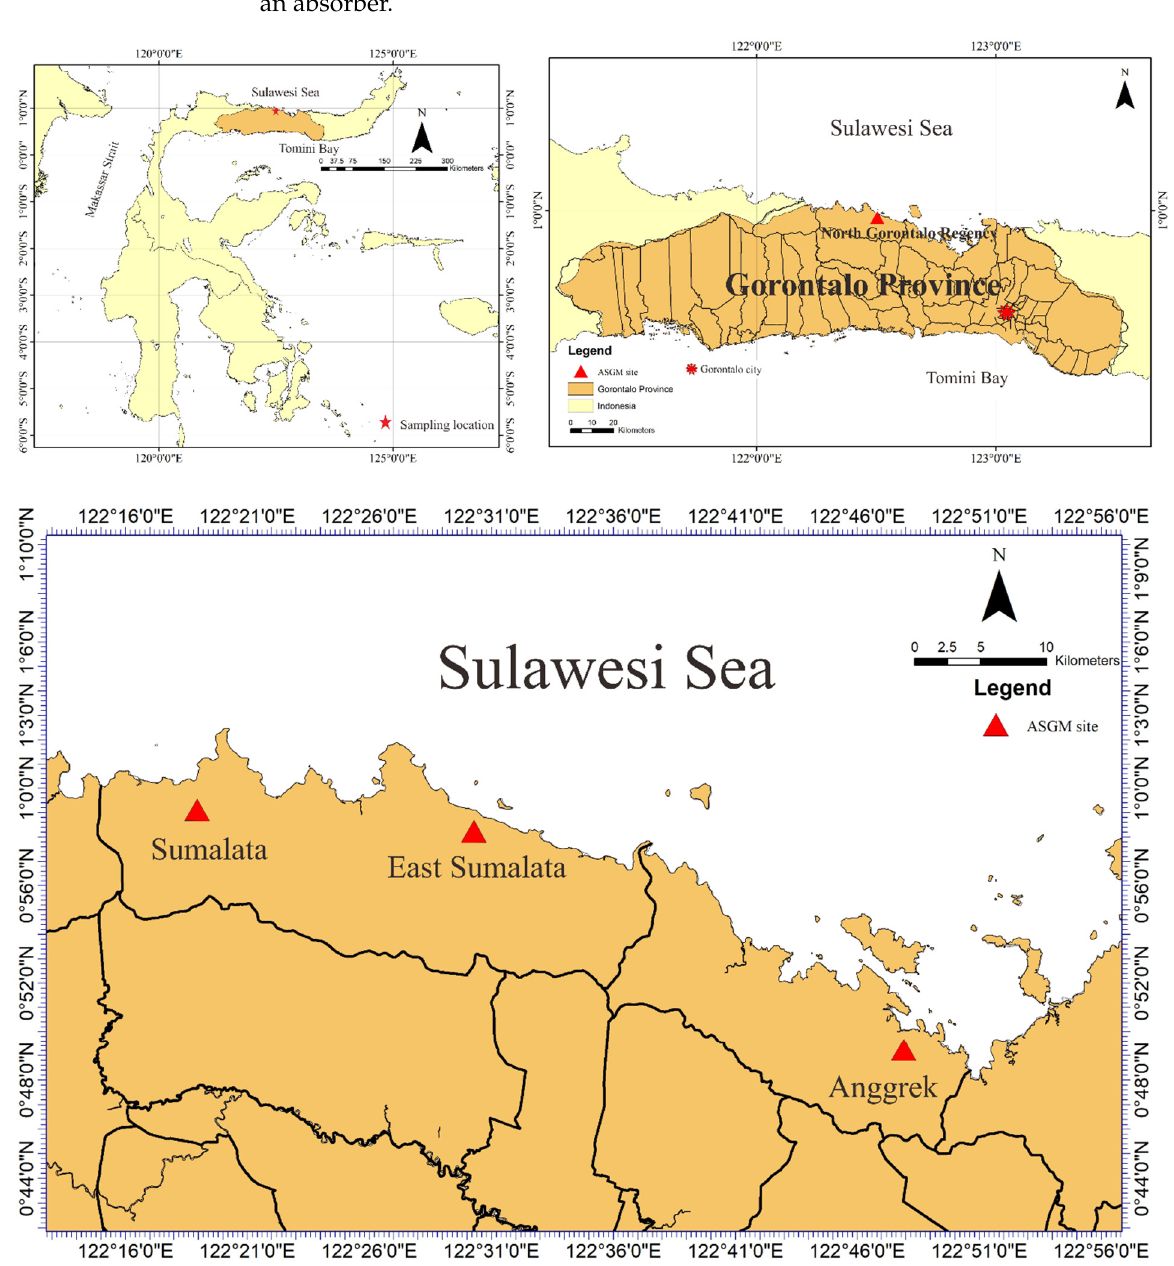
Figure 1. Artisanal and small-scale gold mining (ASGM) sites in North Gorontalo Regency, Gorontalo Province, Indonesia.